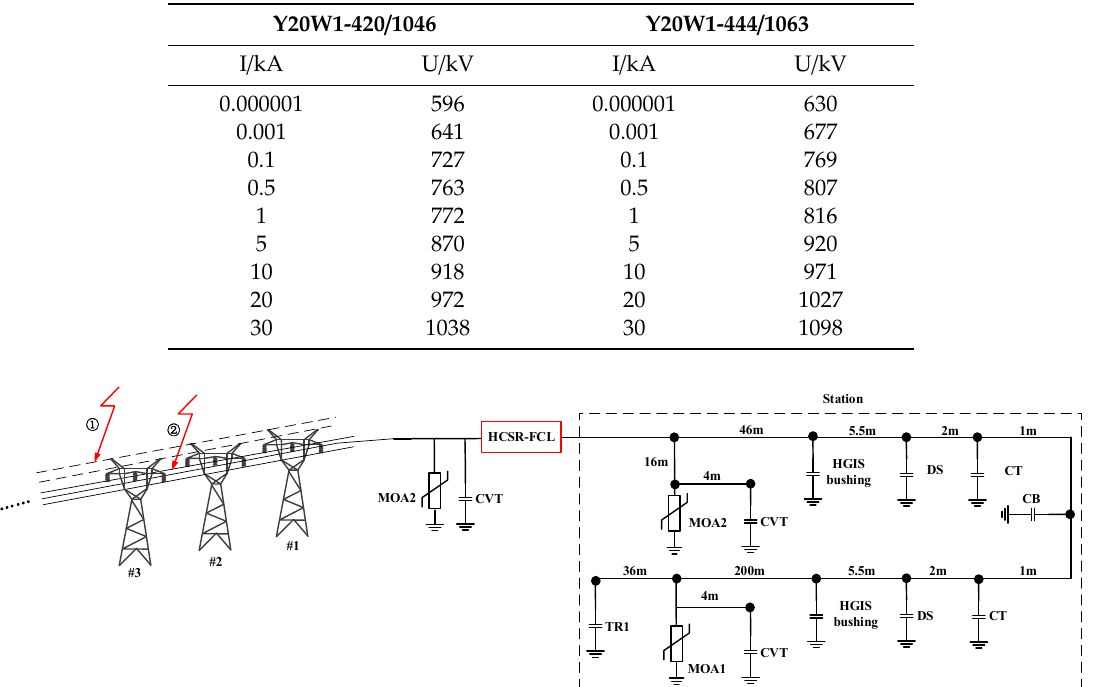
Table 6. U-I characteristics of the arresters.